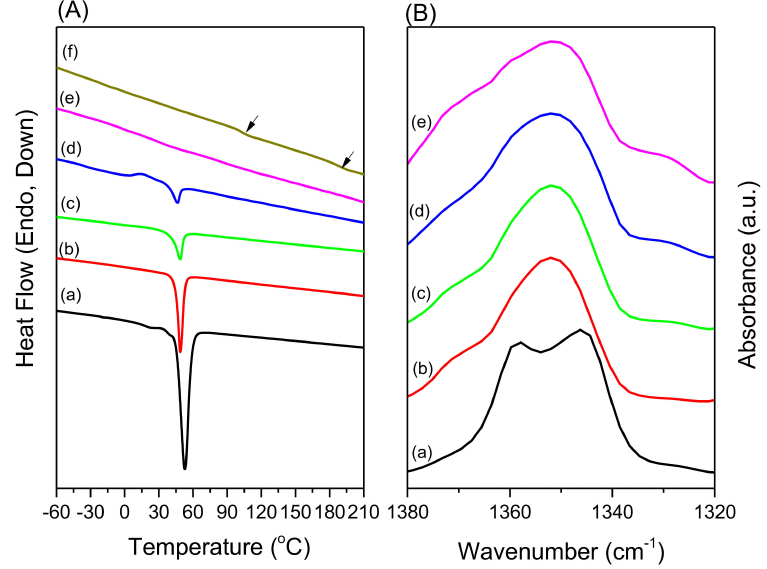
Figure 3. ( A ) DSC and ( B ) FTIR analyses of PS- b -PVPh/PEO blends with different PEO weight